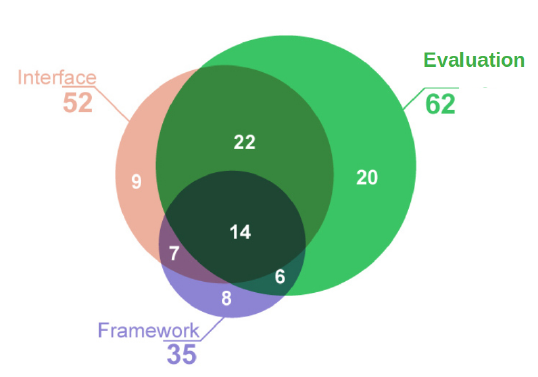
Figura 3. Articles grouped by research axis, after the second filter.